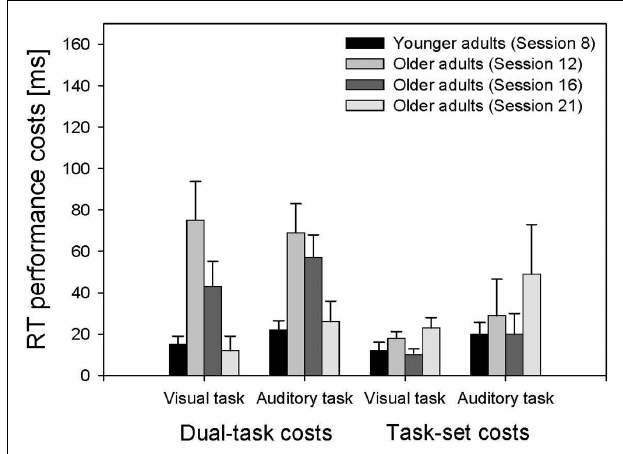
FIGURE 2 | Dual-task and task-set costs in younger adults (Session 8) and older adults (Session 12, 16, 21) in RTs. Session 8 and 12: Strobach et al. (2012b), Session 16: Experiment 1, Session 21: Experiment